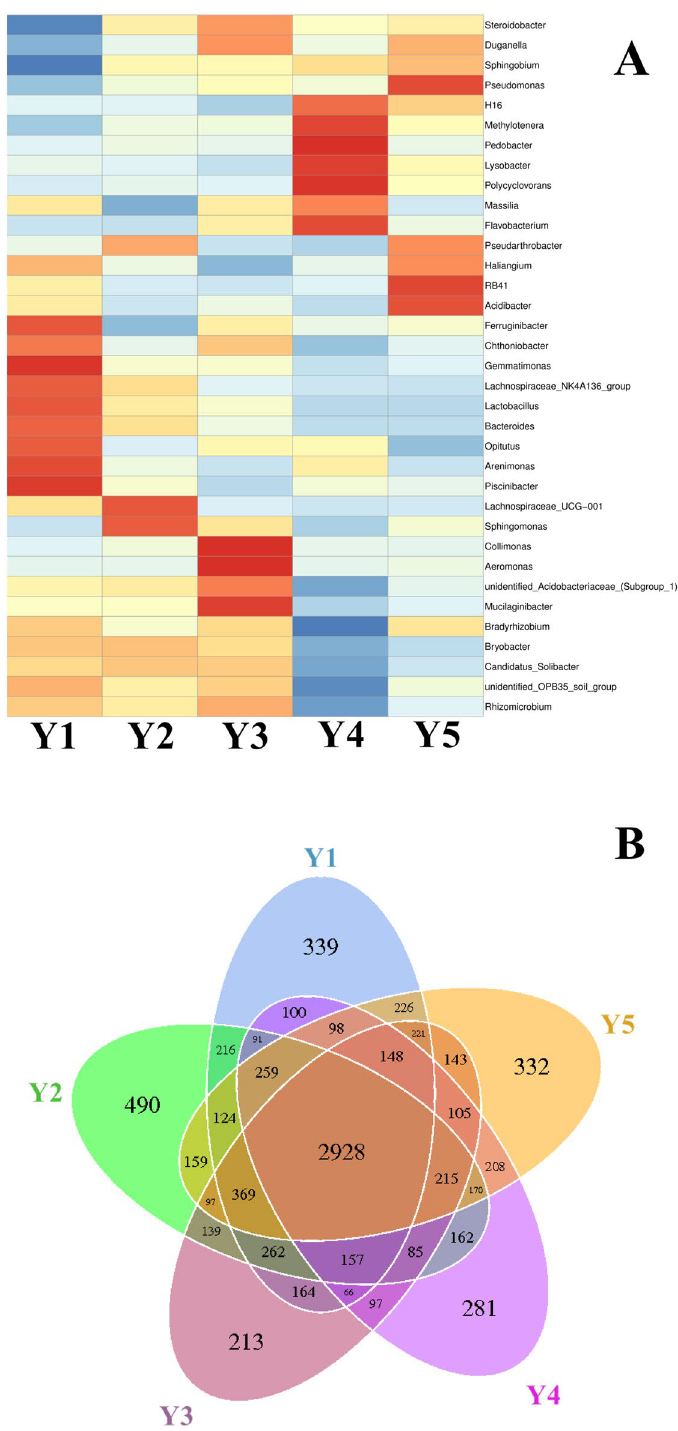
Figure 3. ( A ) Heat map showing the relative abundance of the top 35 most abundant bacterial genera in the samples over years and ( B ) Venn diagram of the OTUs in the samples over years at 97% nucleotide sequence identity similarity, showing the common and specific OTU numbers in the